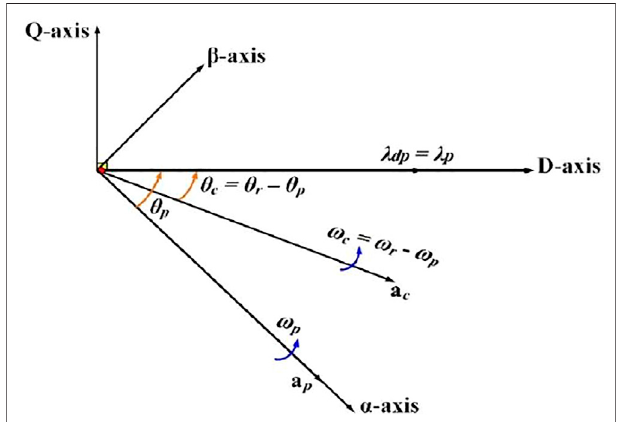
FIGURE 9 | Relationship between phase-axis of BDFRG.